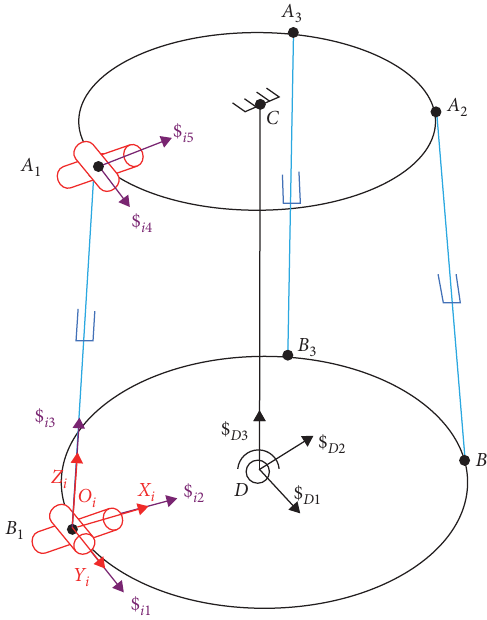
F IGURE 6: The branch coordinate system of the parallel